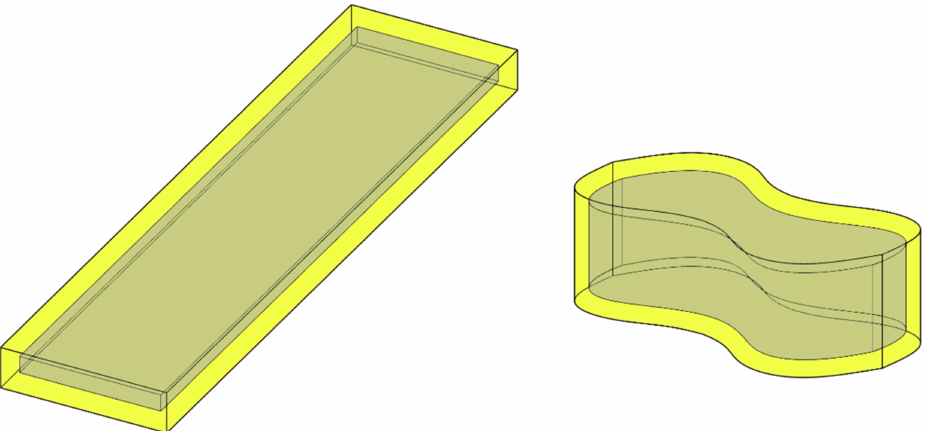
Figure 11. Volume affected by sulfate ingress (yellow, depth: 3 mm): mortar flat prism (10 × 40 × 160 mm 3 , SVA method) and briquet specimen (ASTM C307-03); unaffected volume: grey.